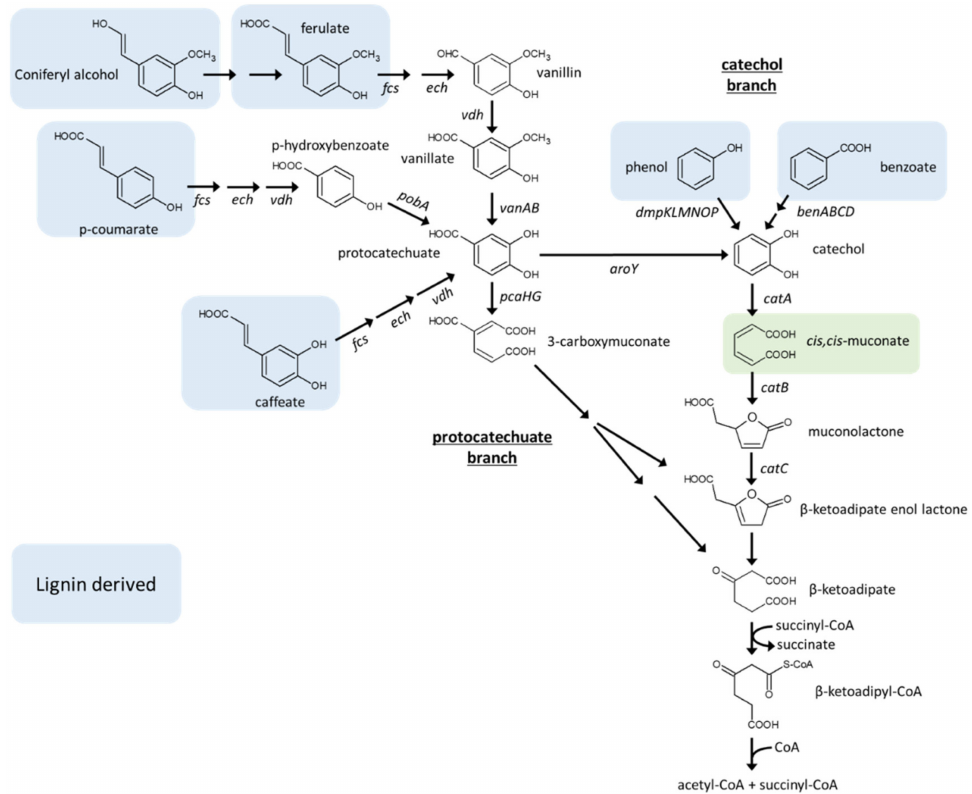
Figure 4. Schematic representation of the protocatechuate (left) and catechol (right) branches of the β -ketoadipate pathway, which funnels different lignin-derived aromatic compounds (highlighted in blue) to β -ketoadipate and, eventually, to the TCA cycle intermediates acetyl-CoA and succi- nate [165,167]. cis , cis -muconate (highlighted in green) is an intermediate of the catechol branch, which is obtained through catechol oxidation catalyzed by catechol 1,2-dioxygenase. aroY , protocat- echuate decarboxylase; benABC , benzoate dioxygenase; benD , dihydroxybenzoate dehydrogenase; catA , catechol 1,2-dioxygenase; catB , muconate cycloisomerase; catC , muconolactone D-isomerase; dmpKLMNOP , phenol hydroxylase; ech , enoyl–CoA hydratase/aldolase; fcs , feruloyl–CoA synthetase; pcaHG , protocatechuate 3,4-dioxygenase; pobA , p-hydroxybenzoate hydroxylase; vanAB , vanillate O-demethylase; vdh , vanillin